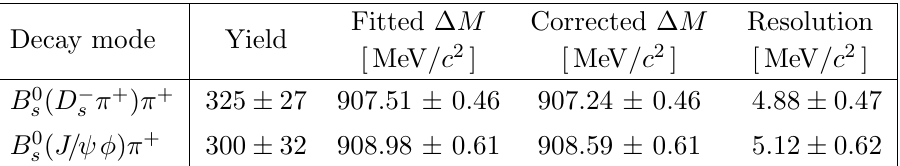
Figure 2. Distributions of mass di(cid:11)erence (cid:1) m for the B + B 0 ( J= (cid:30) ) (cid:25) + decay modes, where data are shown as the points with error bars; the total (cid:12)ts are s shown as solid blue curves; the signal component are red dotted curves; the background components purple dotted curves.